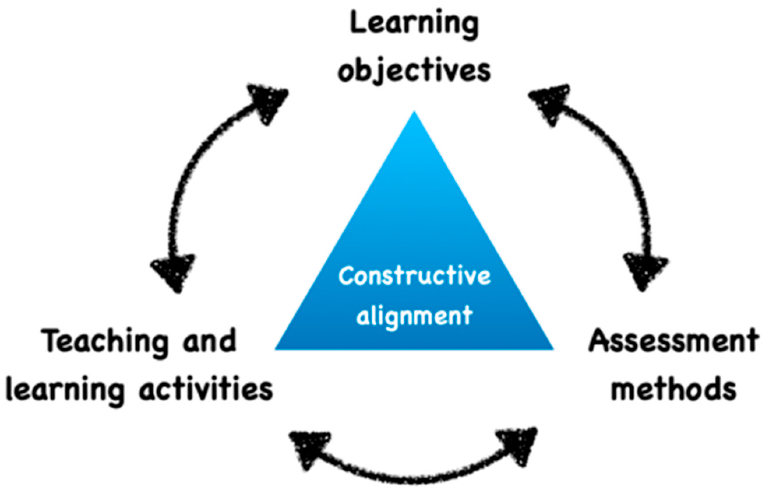
Figure 1. Concept of educational alignment between the objectives, teaching context and activities.